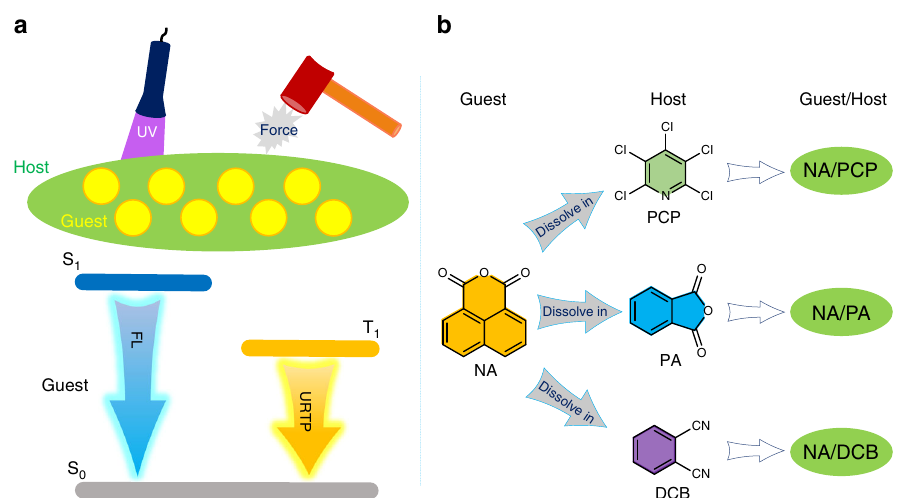
Fig. 1 Design of the guest/host system. a Schematic illustration of the guest/host system, i.e., solid-state solutions where guest is the solute and host is the solvent, showing UV/mechano-excited ultralong room temperature phosphorescence (URTP). FL: fl uorescence. b Compound structures studied in this work. Abbreviations: PCP for pentachloropyridine, PA for phthalic anhydride, DCB for 1,2-dicyanobenzene and NA for 1,8-naphthalic